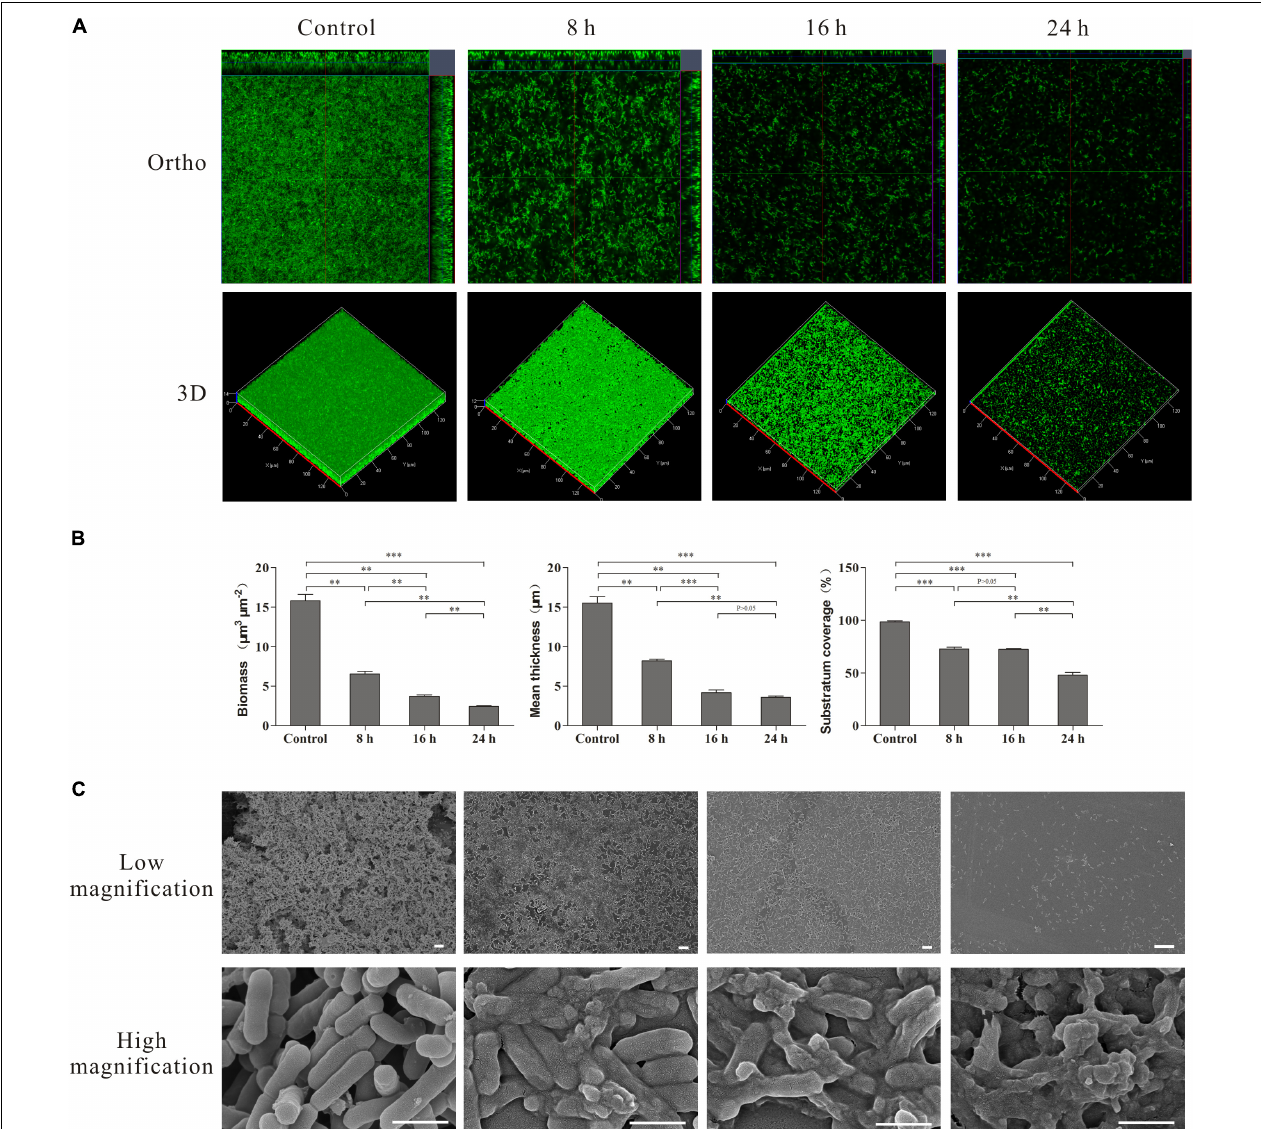
FIGURE 5 | CLSM, SEM images and COMSTAT analysis of the L. monocytogenes biofilms untreated (Control) and treated by linalool for different time (8, 16, and 24 h). (A) CLSM photography. (B) COMSTAT analysis. Bars represented the mean values (Mean ± SD; n = 3). (C) SEM photography. The scale bar represented 500